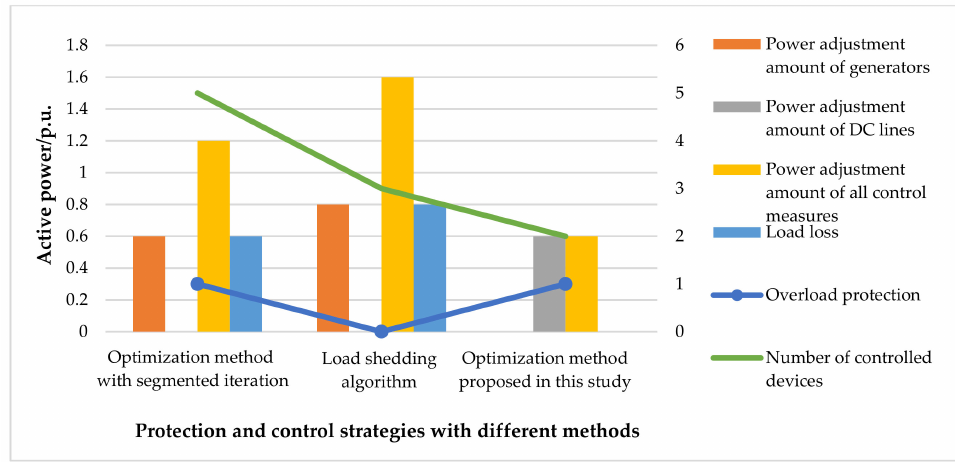
Figure 10. Comparison of different